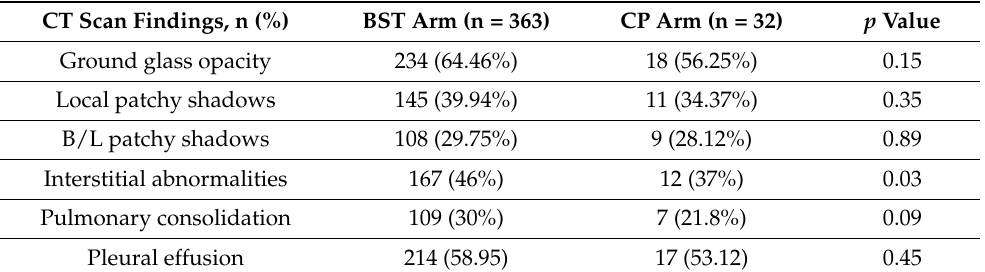
Table 3. Baseline radiological features of critically ill COVID-19 patients of best standard treatment group (n = 363) and convalescent plasma treatment group (n =